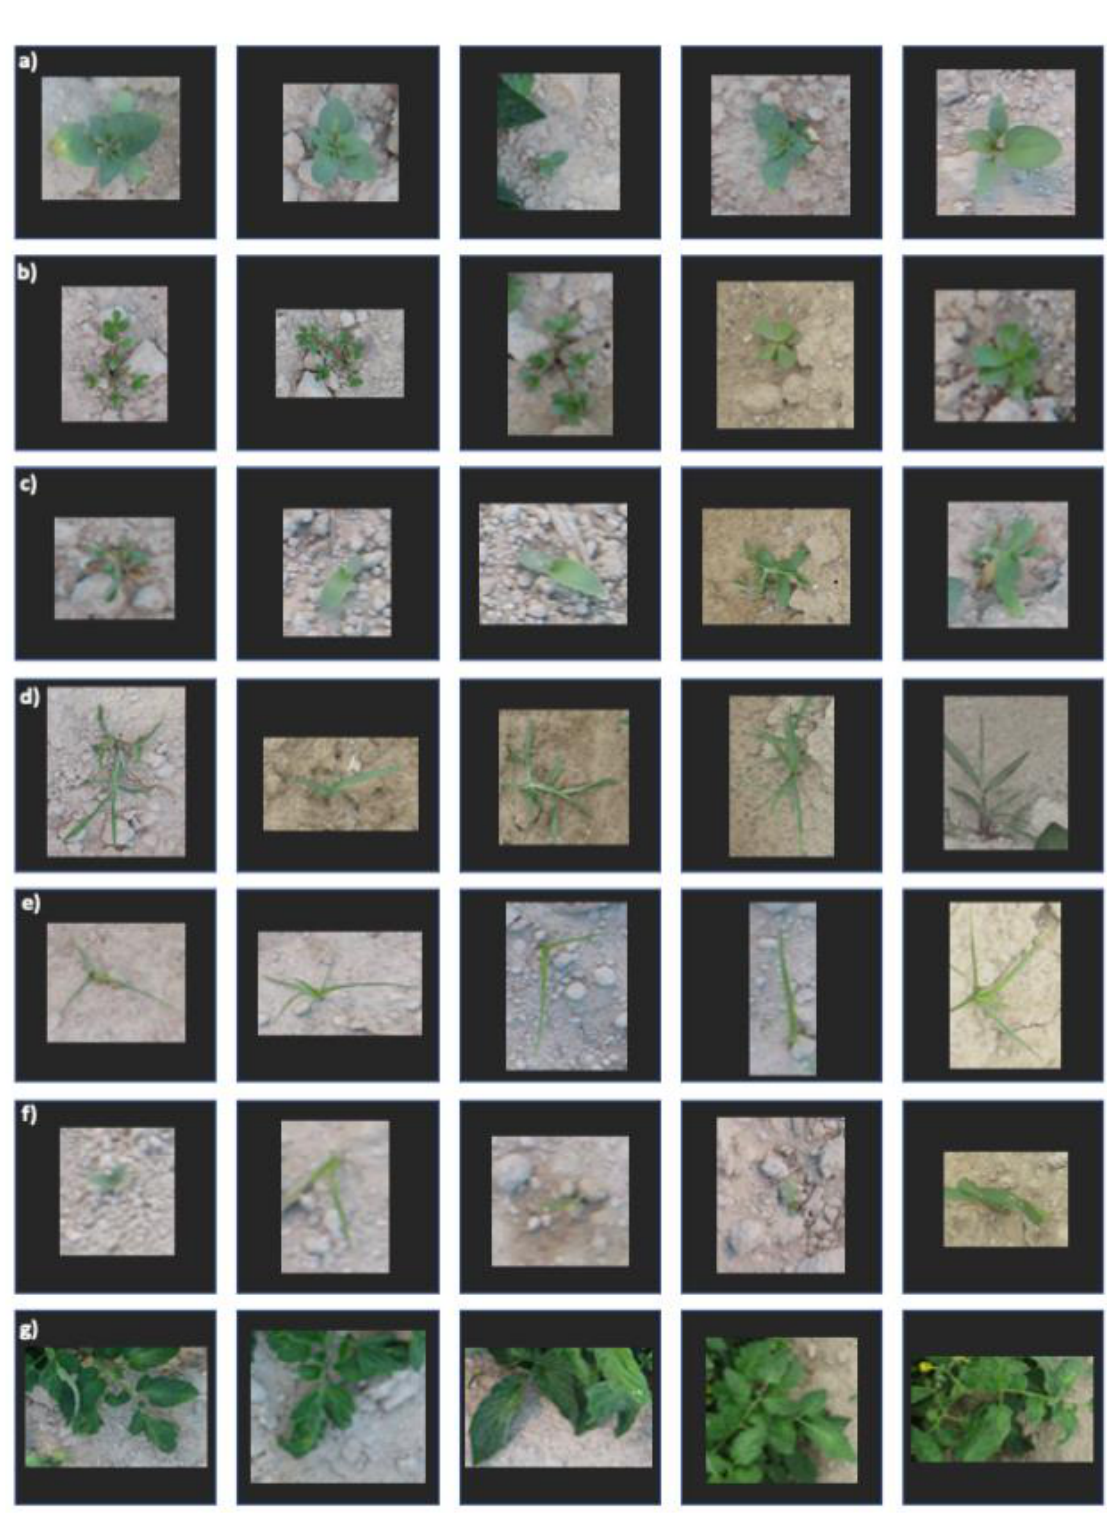
Figure A1. Representations of dataset by classes. ( a ) Solanum nigrum L., ( b ) Portulaca oleracea L., ( c ) Setaria verticillata L., ( d ) Echinochloa crus galli L., ( e ) Cyperus rotundus L., ( f ) Not recognised , ( g ) Solanum lycopersicum L.